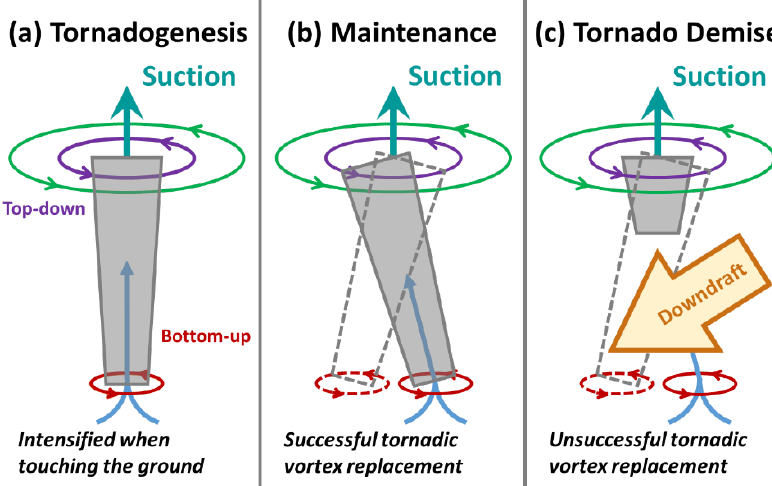
Figure 12. Schematic diagrams of the ( a ) genesis, ( b ) maintenance and ( c ) demise processes of the Beijing tornado event based on the idealized simulation. The suction and circulation of the midlevel mesocyclone are denoted by the cyan arrow and green circle, respectively. The circulation of the enhanced moderate rotation of the midlevel mesocyclone is denoted in purple, which develops top-down toward the ground. The stronger rotation at the ground is denoted by red circles. Blue arrows denote the stretching of the near-surface tornadic vortices. The grey column denotes the tornado funnel cloud. The dashed lines in ( b ) and ( c ) denote the weakened former tornado column. The brown arrow in ( c ) denotes the strengthened downdraft that cuts off the connection between the newly developed near-surface tornadic vortex and the suction of the midlevel mesocyclone.